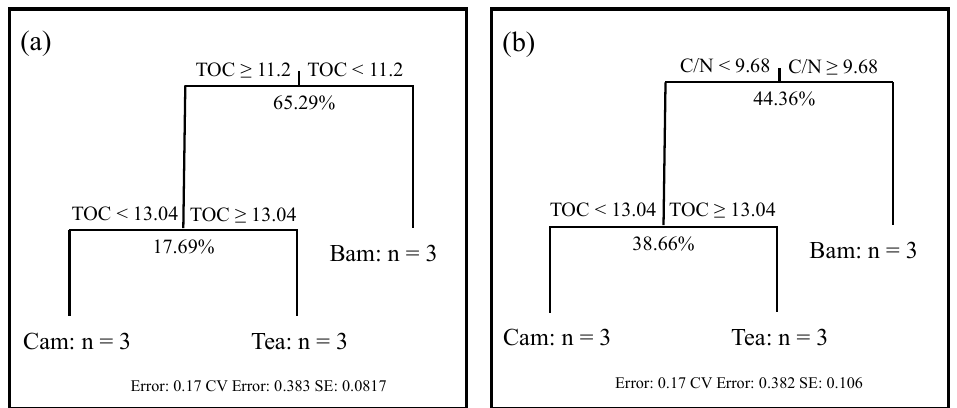
Figure 5. Multivariate regression tree (MRT) of soil bacterial ( a ) and fungal ( b ) communities from bamboo (Bam), camphor (Cam), and tea (Tea) plantations. TOC, total organic carbon; C/N, ratio of carbon to nitrogen.